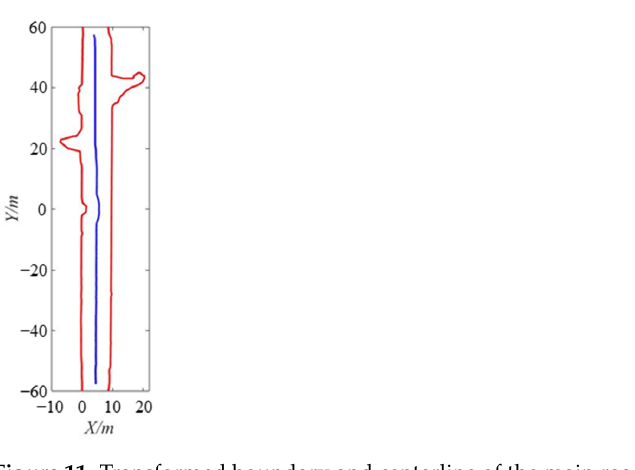
Figure 12. Longitudinal gradient.